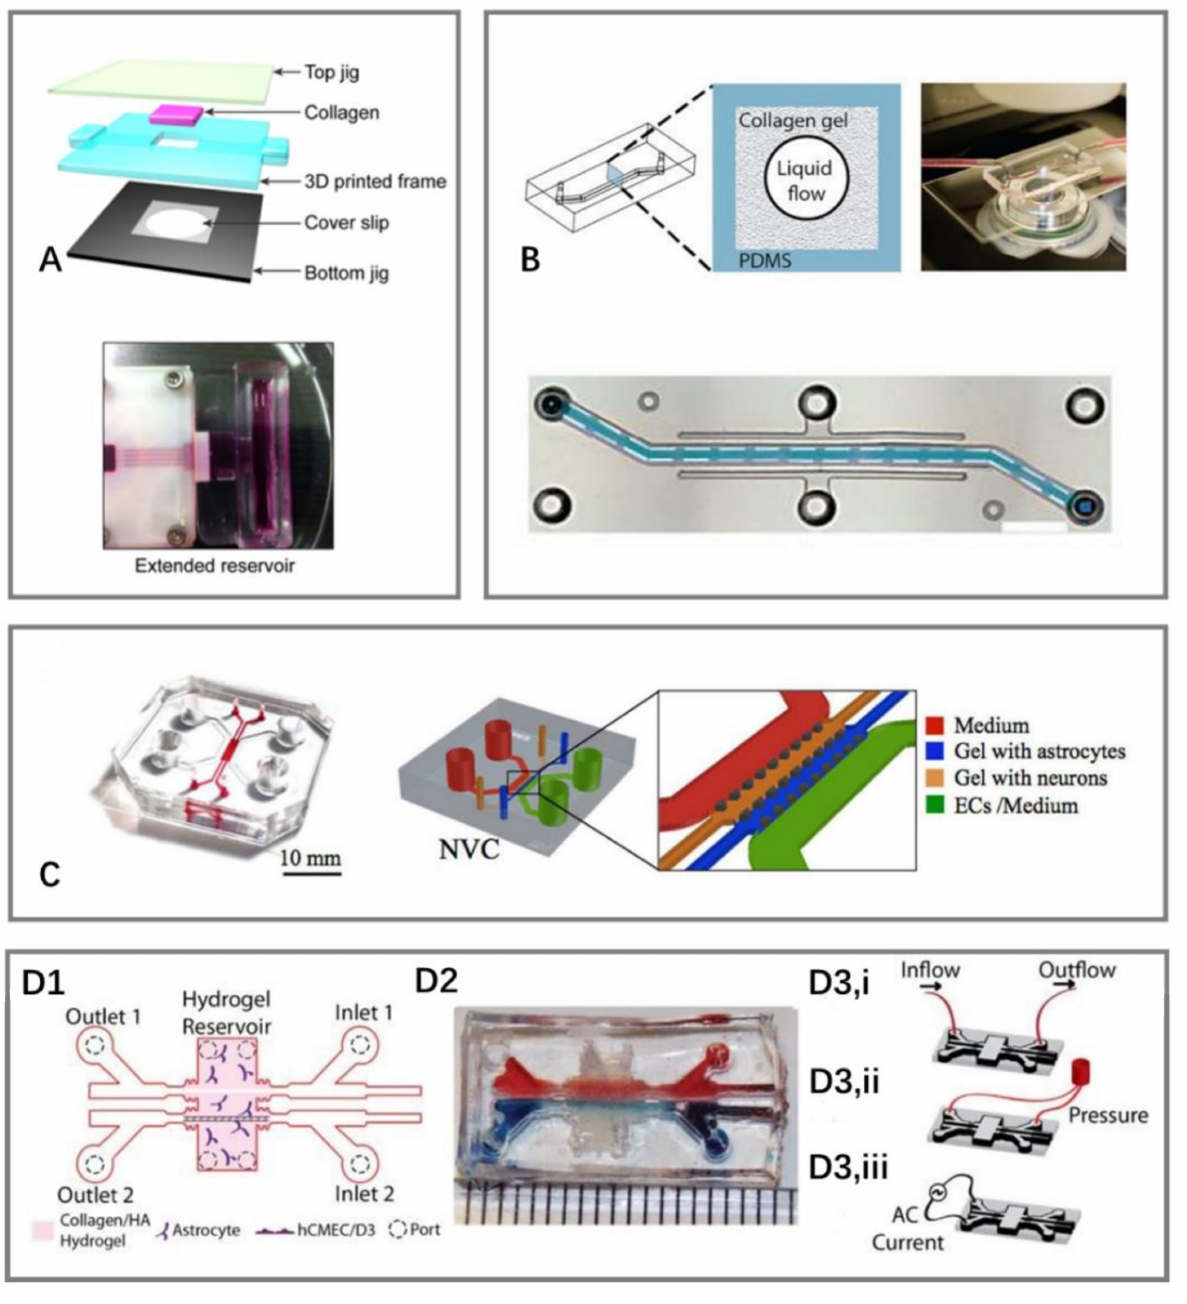
Figure 4. Schematic of different 3D models of BOCs. ( A ) A 3D microfluidic chip for 3D culture, where microchannels were fabricated by microneedles [85]. ( B ) Microchannels fabricated by viscous fingering to generate lumens in collagen gels [86]. ( C ) A 3D self-assembled microvascular microfluidic chip [87]. ( D ) A 3D BBB model that allows for TEER measurement. ( D1 ) Schematic of the structure of a microfluidic device. ( D2 ) Picture of the device with food dye injected into the two channels. ( D3 ) Testing configurations ( i ) application of fluid flow, ( ii ) cyclic strain stimulation, and ( iii ) TEER measurements